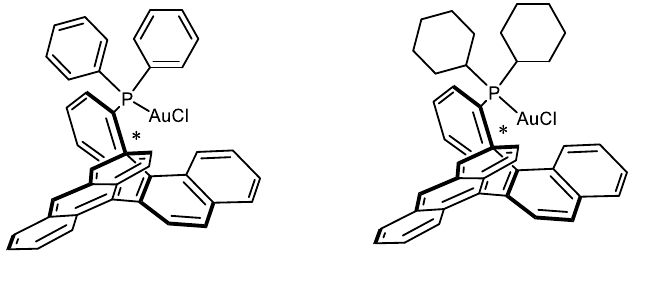
Figure 5. JoyaphosCl complexes.